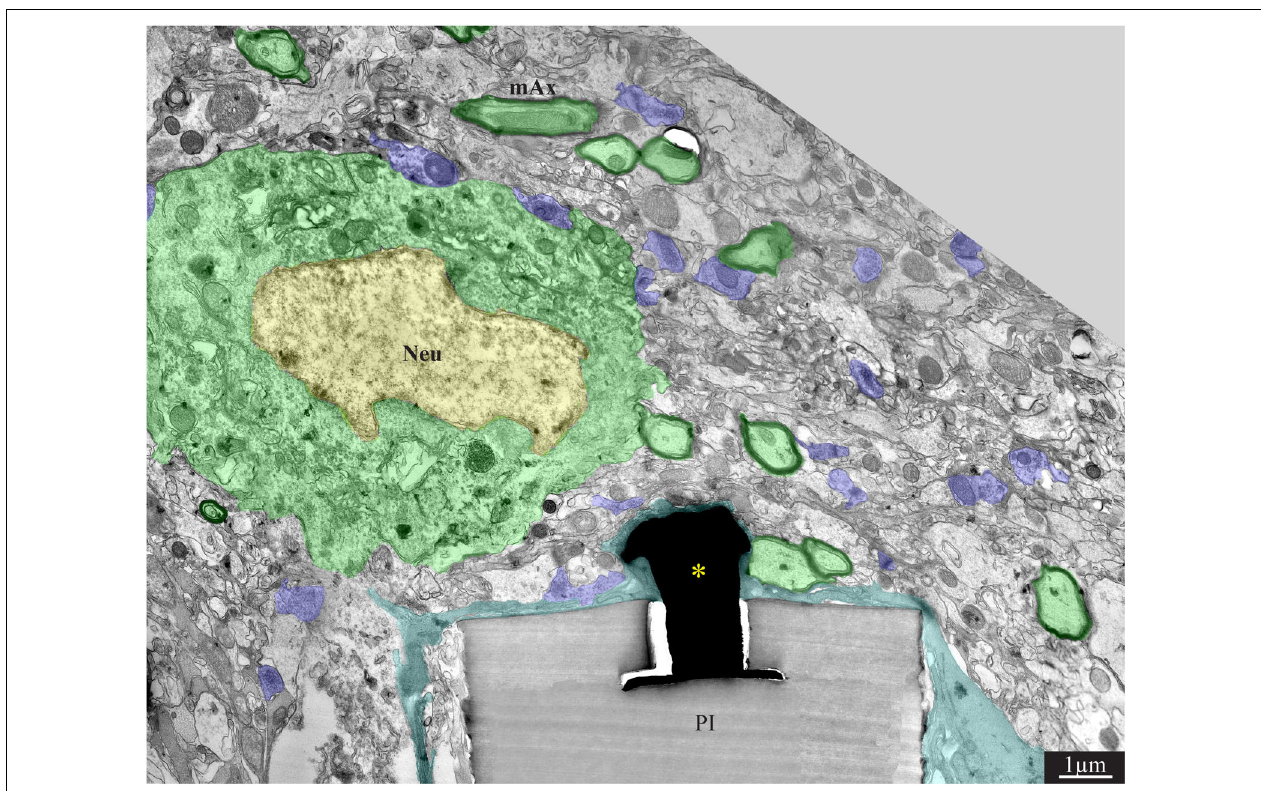
FIGURE 6 | A low magnification, transmission electron microscope image of the interfaces formed between a gold mushroom shaped microelectrode extending from a polyimide platform implanted for 8 weeks and the surrounding cortical tissue. The mushroom shaped microelectrode (black) immerges from the PI substrate (gray). A thin layer of dark microglia (cyan) adheres tightly to the gM µ E and the PI substrate. A neuronal cell body with a typical nuclear structure (yellow) and cytoplasm (green) resides approximately a micrometer away from the gM µ E and the PI platform’s surface. Myelinated axons (green surrounded by a black sheath) are distributed in the parenchyma in contact with the microglia that adheres to the platform. Unmyelinated neurites and synaptic structures (labeled purple) were identified (using large magnification of the image) by the presence of presynaptic vesicles. The remainder of the unmarked profiles are astrocyte branches and non-myelinated neurites. PI, polyimide ribs; gM µ E, yellow asterisks; Neu, neuron; mAx, myelinated axons. Note that an unmarked copy of this figure is presented as Supplementary Figure 7